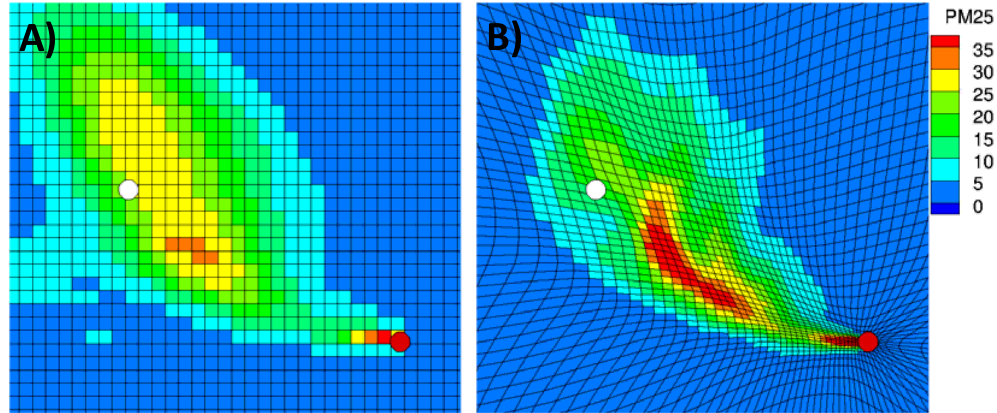
concentrations ( μ gm − 3 ) on April 9, 2008 at 19:45 GMT using Figure 18. Simulated PM 2.5 ( A ) CMAQ; and ( B ) AG–CMAQ. Locations of the prescribed fire at Ft. Benning and the Columbus airport air quality monitoring site are indicated by red and white circles respectively.